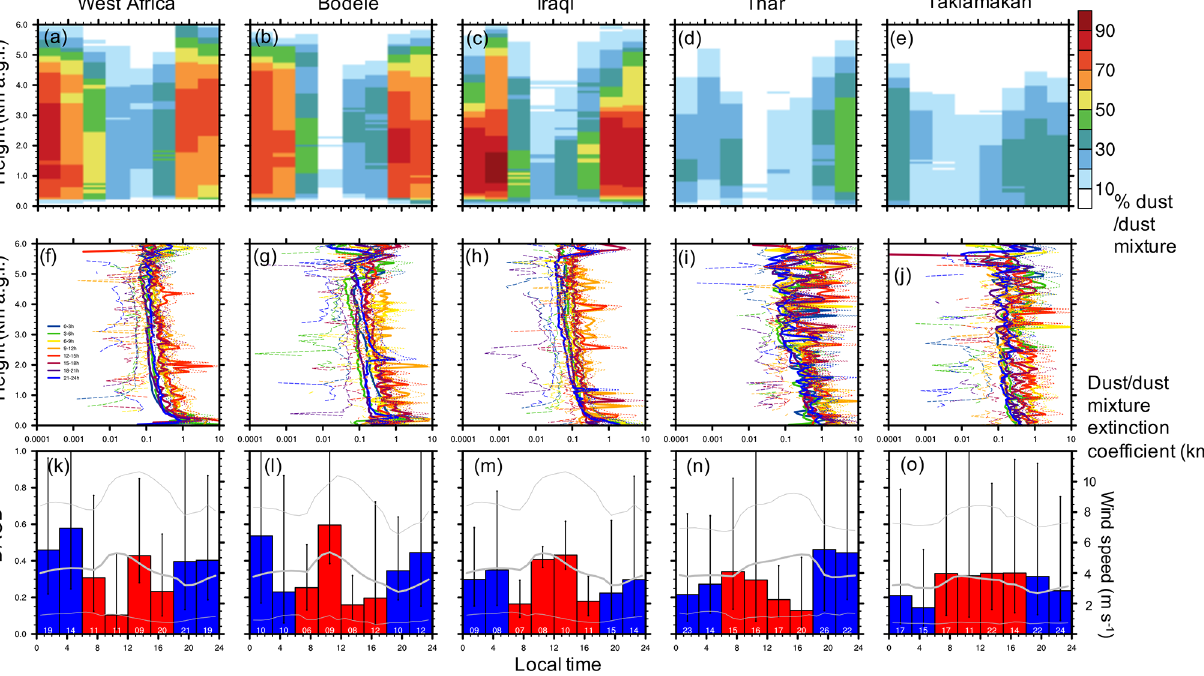
Figure 12. Diurnal cycle of dust and dust mixture characteristics observed by CATS over five key dust source regions during boreal summer (June–August, JJA). Figure elements are the same as in Fig.